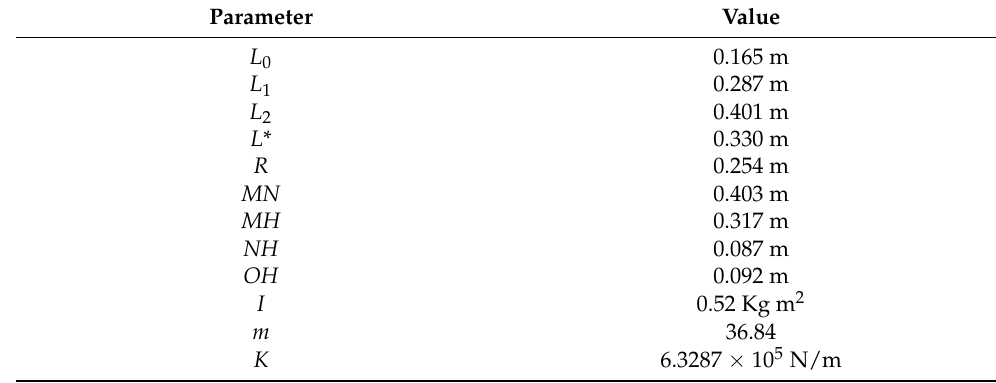
Table A1. Reference landing gear input data: geometric characteristics, inertial properties and stiffness along the x -axis